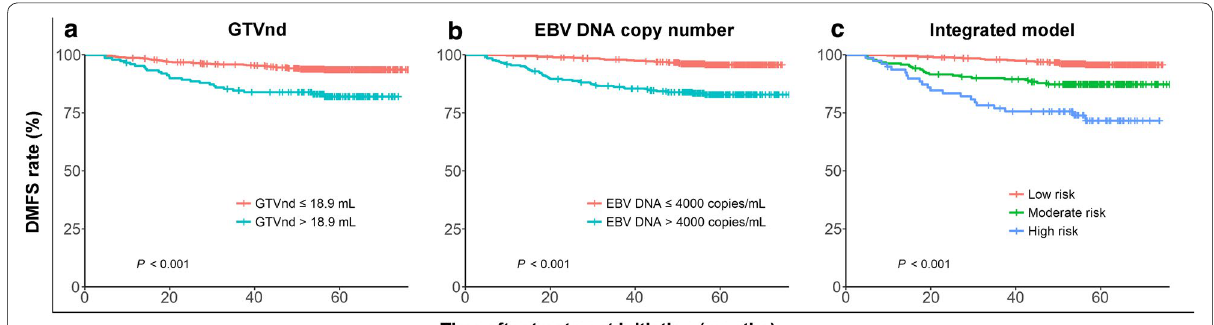
Fig. 1 Kaplan–Meier distant metastasis‑free survival curves for patients with N1 nasopharyngeal carcinoma stratified by a gross tumor volume of lymph node (GTVnd), b serum Epstein–Barr virus (EBV) DNA copy number, and c prognostic model. Low risk: EBV DNA of GTVnd; moderate risk: GTVnd 18.9 mL with EBV DNA > 4000 copies/mL; high risk: GTVnd > 18.9 mL with EBV DNA > 4000 copies/mL. DMFS ≤ distant metastasis‑free